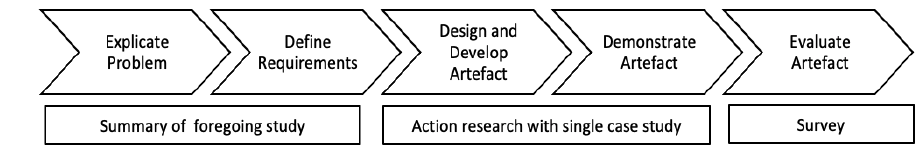
Figure 1. Design Science Research Method Framework of Johannesson and Perjons [51] amended by applied research